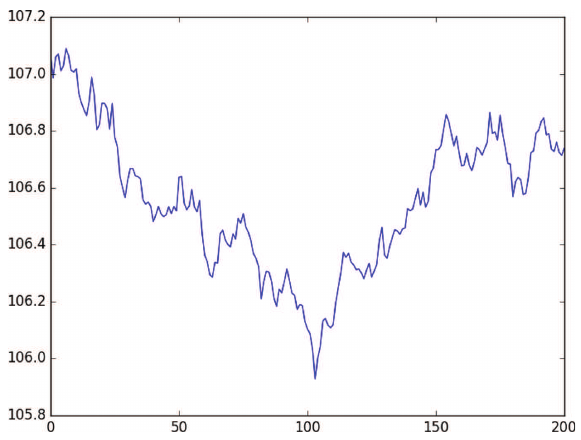
Figure 8: One of the Simulation Data Generated by the GBM